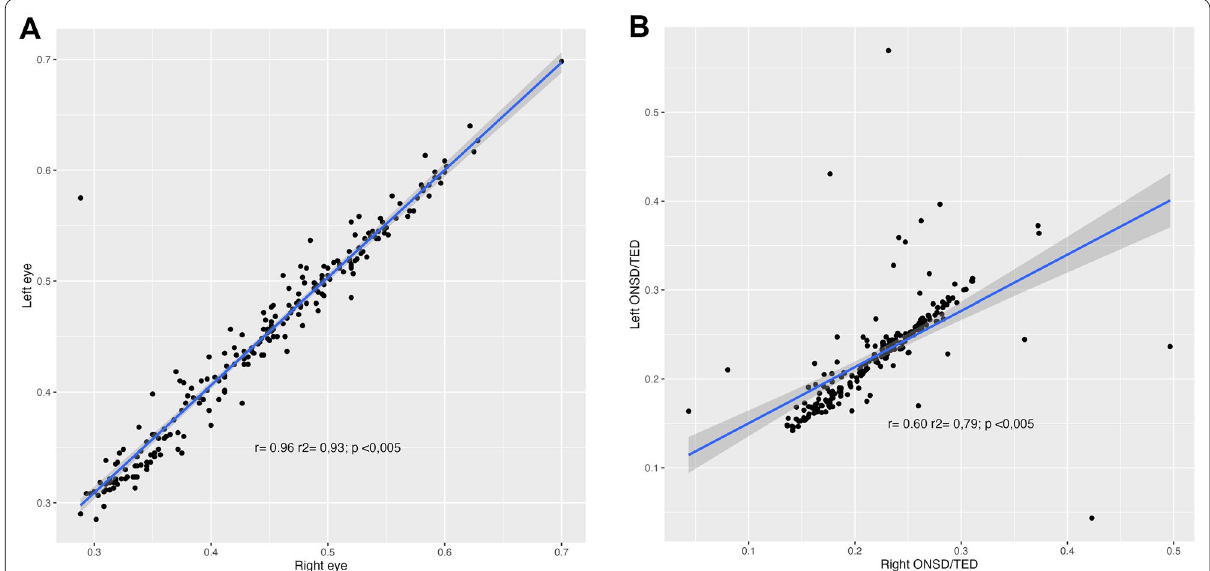
Fig. 2 A : Optic nerve sheath diameter (ONSD) relation between right eye and left eye. B : Optic nerve sheath diameter/transverse diameter of the eyeball (ONSD/ETD) relation between right eye and left